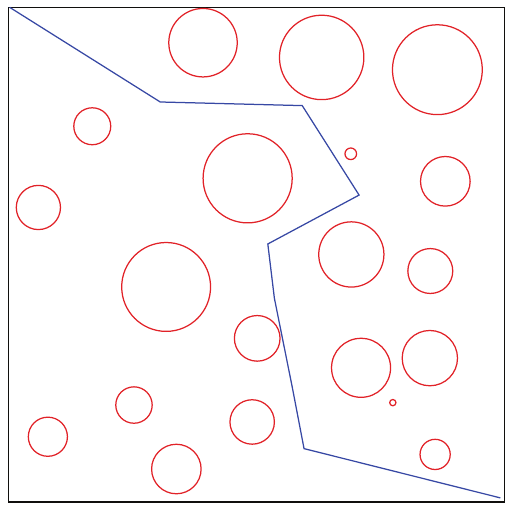
Figure 17: Test environment III. Table 3: Comparison in performance among the proposed hybrid approach, PSO, and GA for test environment I.